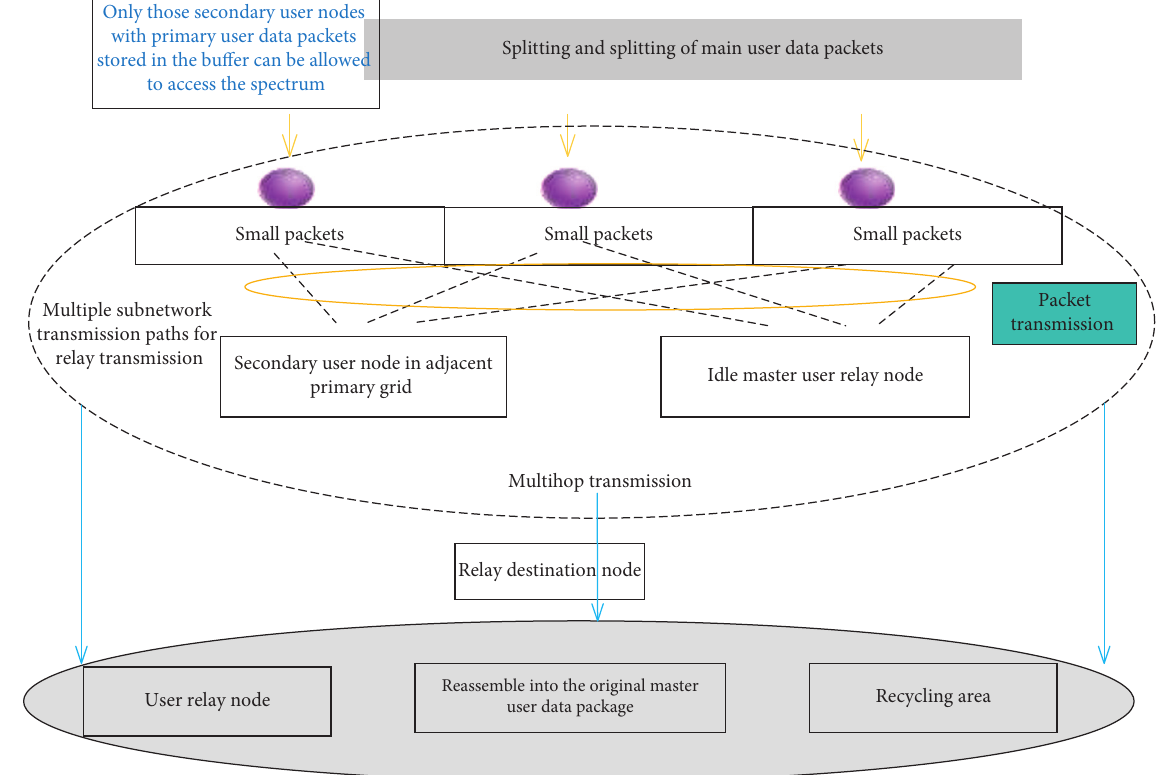
Figure 3: Primary user data packet transmission process based on static cooperative secondary